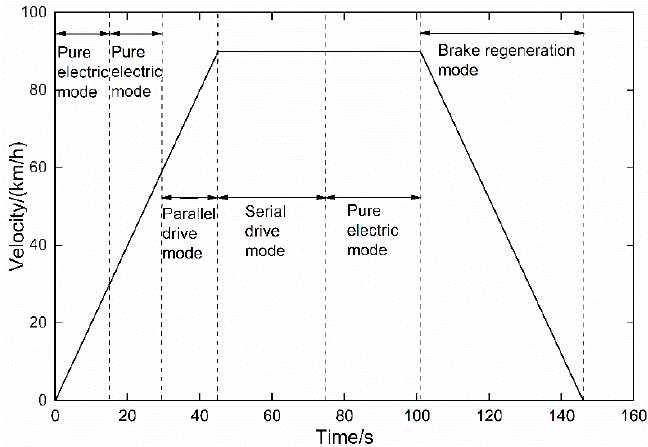
Figure 10. Stage division.